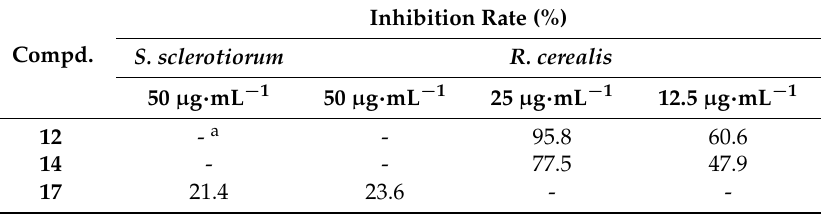
Table 3. Fungicidal activity of compounds 12 , 14 , 17 against S. sclerotiorum and R. cerealis.